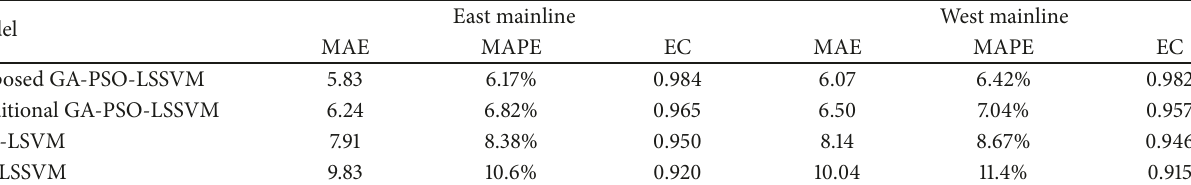
Table 4: Forecasting performance comparison of different methods.